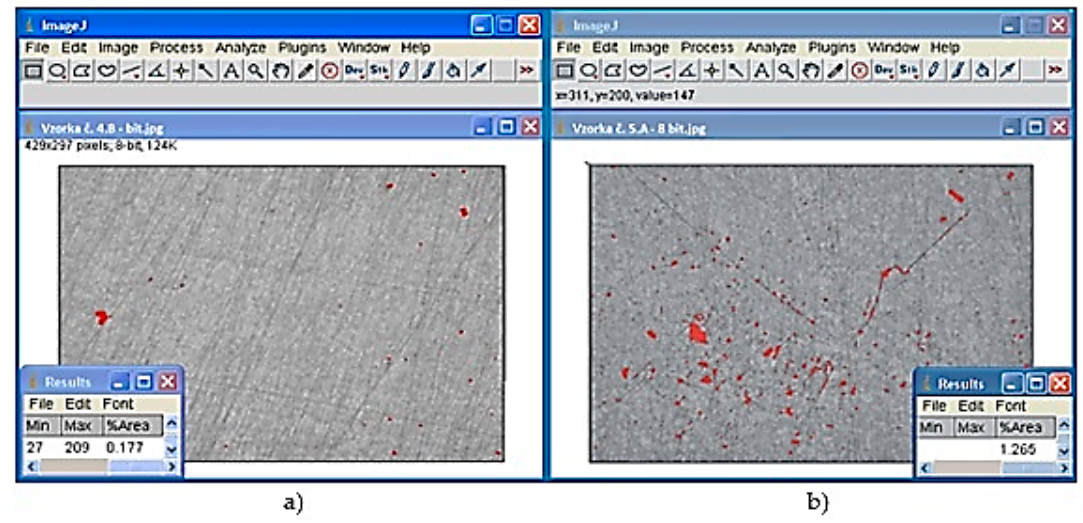
Figure 4. Evaluation of porosity by the ImageJ program ( a ) content of pores in the case of the 4B sample ( b ) content of pores in the case of the 5A sample.